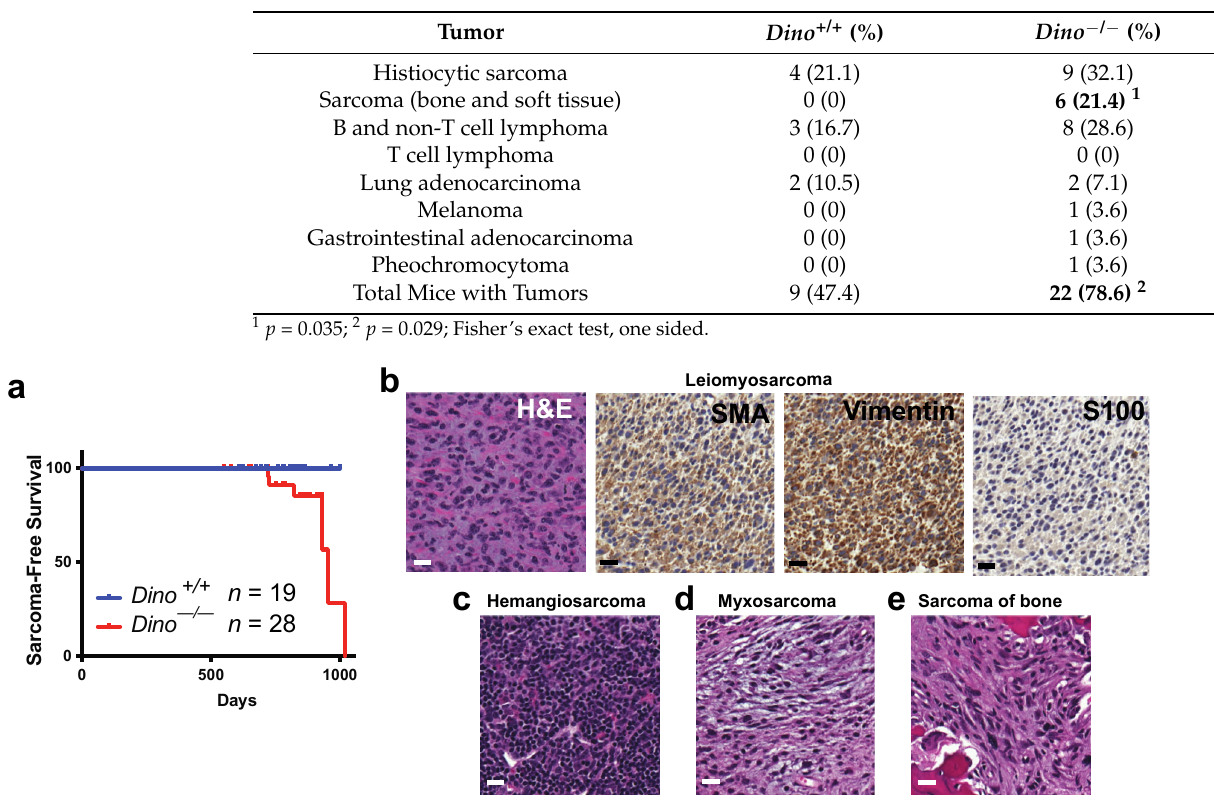
Figure 1. Dino − / − mice spontaneously develop soft-tissue and bone sarcomas. ( a ) Kaplan–Meier plot of sarcoma free-survival in Dino +/+ and Dino − / − mice; 6/28 Dino − / − mice developed sarcoma over their lifespan compared to 0/19 Dino +/+ mice. ( b ) Leiomyosarcoma of the hind limb. Representative images of H&E staining and diagnostic immunohistochemistry showing strong positive staining for vimentin and α -SMA ( ≥ 90%) and negative staining for S100 ( ≤ 5%). ( c ) Hemangiosarcoma of the liver (H&E). ( d ) Myxosarcoma arising from the muscle of the abdominal wall (H&E). ( e ) Sarcoma of the bone most likely represents osteosarcoma (H&E). All images taken 40X, scale bar = 20 µm.